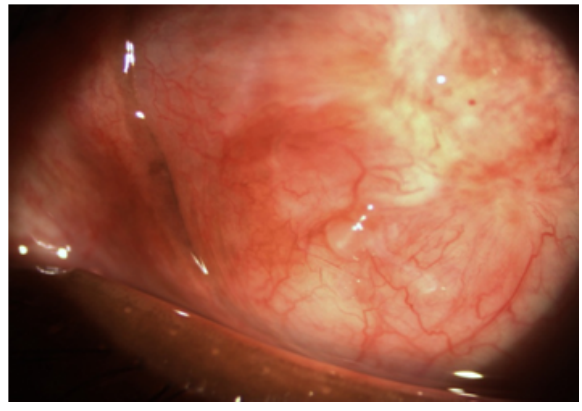
Figure 7: Appearance of the wound bed after cryotherapy and